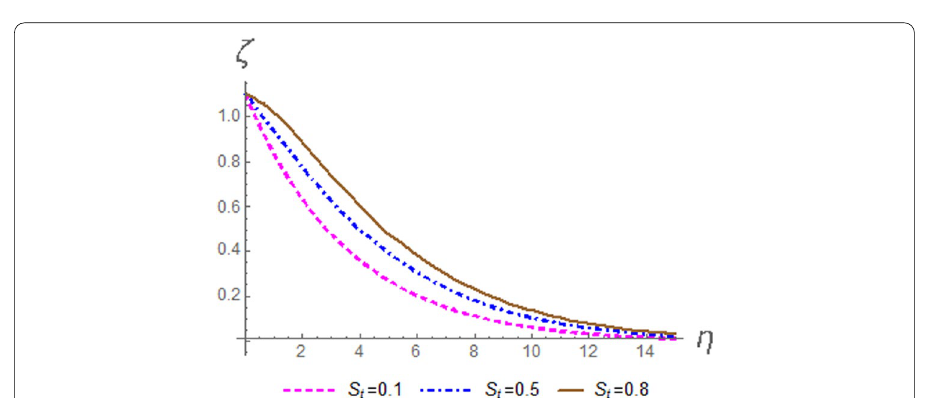
Fig. 15 Effect of S t on the concentration